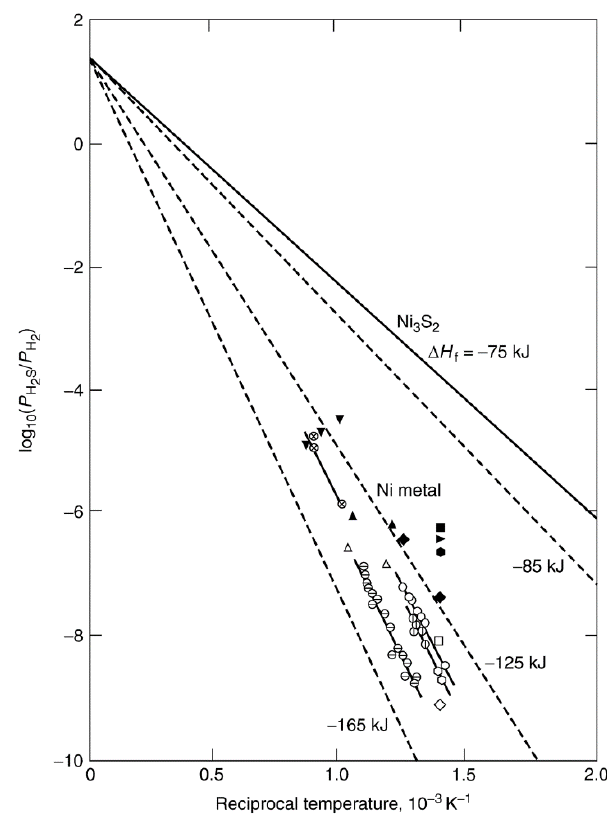
Figure 4. Equilibrium partial pressure of H 2 S versus reciprocal temperature (values of Δ H f based on 1 mole of H 2 S); open symbols: θ = 0.5–0.6; closed symbols: θ = 0.8–0.9. Reproduced from [28]. Copyright 1982, Academic Press.